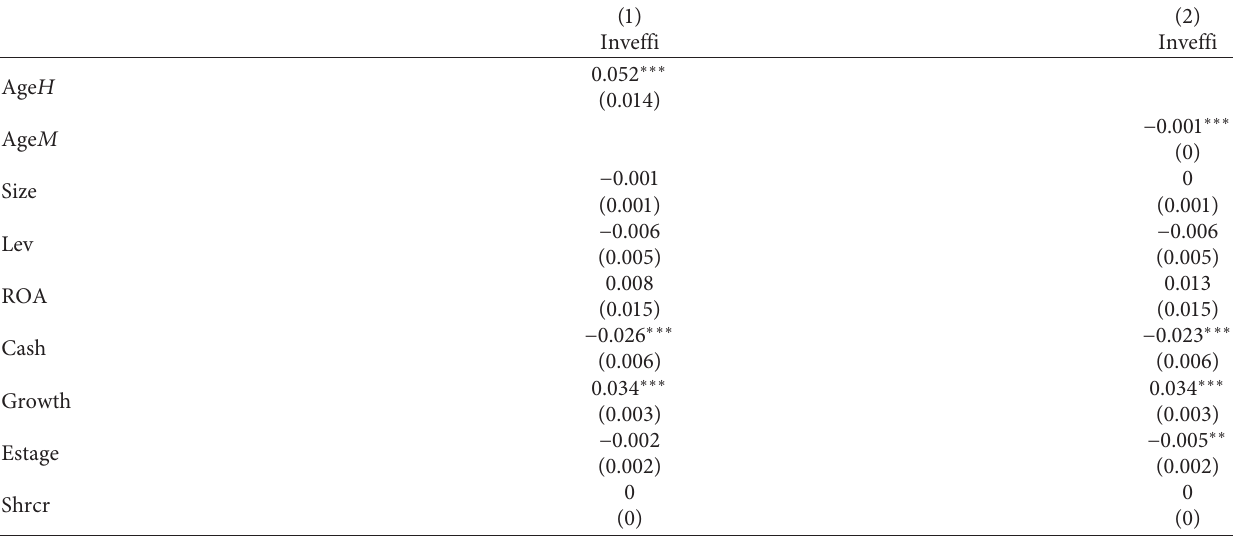
Table 5: Regression results of the relationship between age characteristics of board members and investment efficiency of refinancing